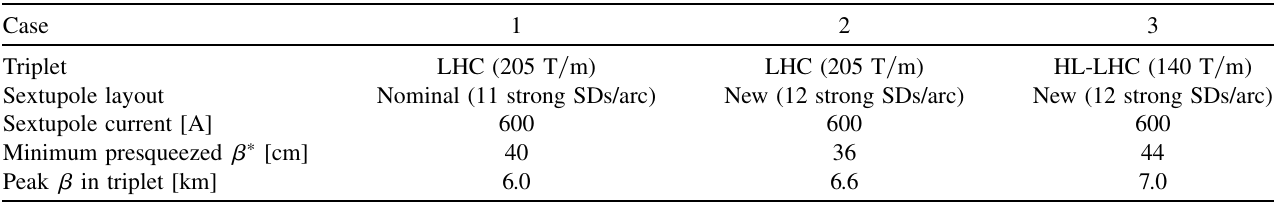
TABLE I. Minimum possible presqueezed (cid:1) (cid:1) in various cases for the LHC and HL-LHC at an energy 7 TeV = beam (aperture requirements not included in the case of the existing LHC triplets).